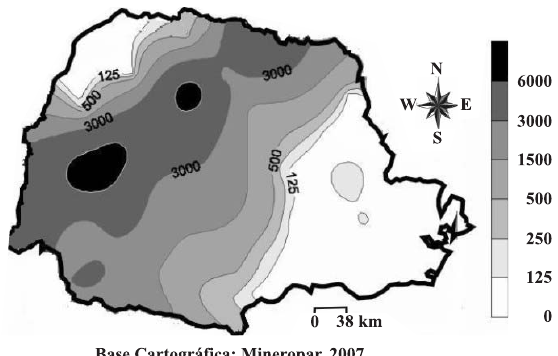
Figura 2. Mapa das sete classes de valores de suscetibilidade magnética por unidade de massa ( χχχχχ ) (10 -8 m 3 kg -1 ) propostas para o Estado do BF